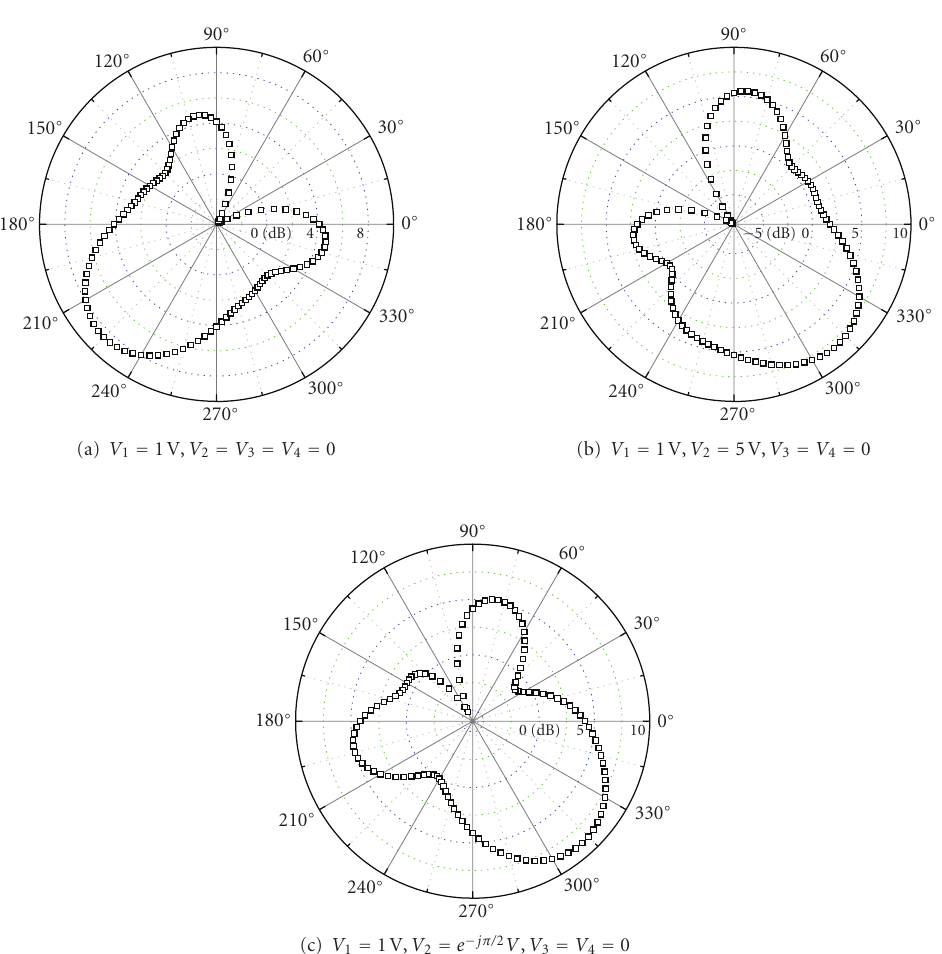
Figure 14: H-plane gain patterns of a four-monopole antenna ( f = 2 . 45GHz, D = 61 . 26mm, θ = 90 ◦